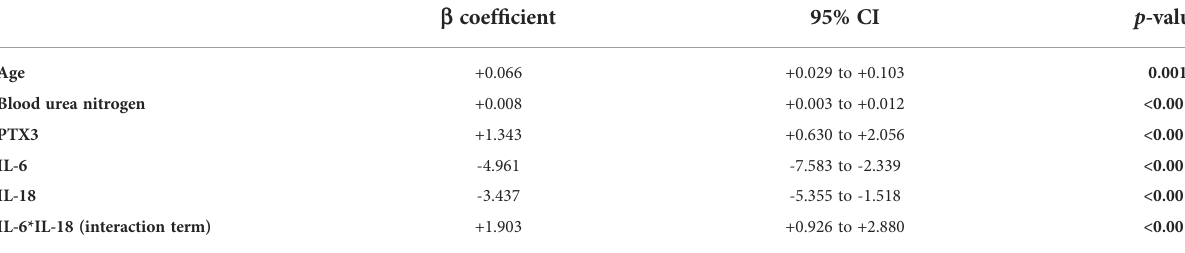
TABLE 8 Multivariable Cox model of 90-days mortality: full model speci fi cation 1